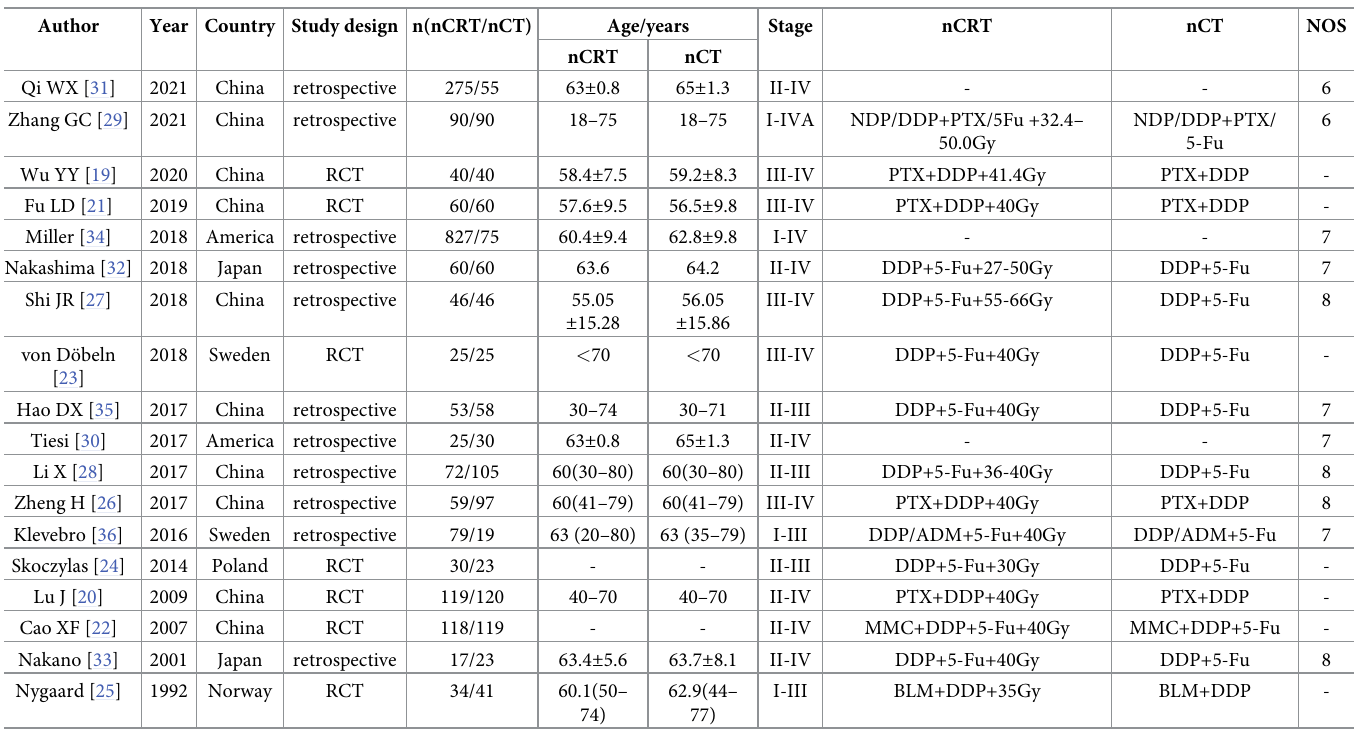
Table 1. The characteristics of studies